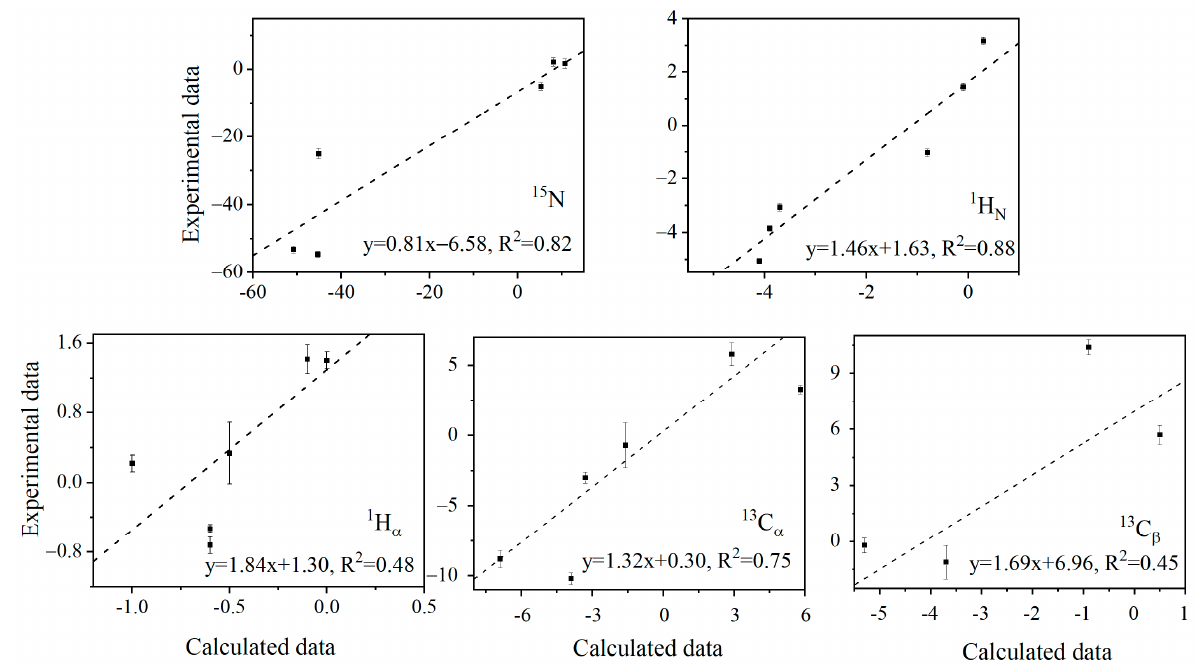
Figure 3. Correlation of λ values from the experimental fitting of ∆ δ s to Equation (1) for different nuclei and from the ONIOM/DFT calculations.